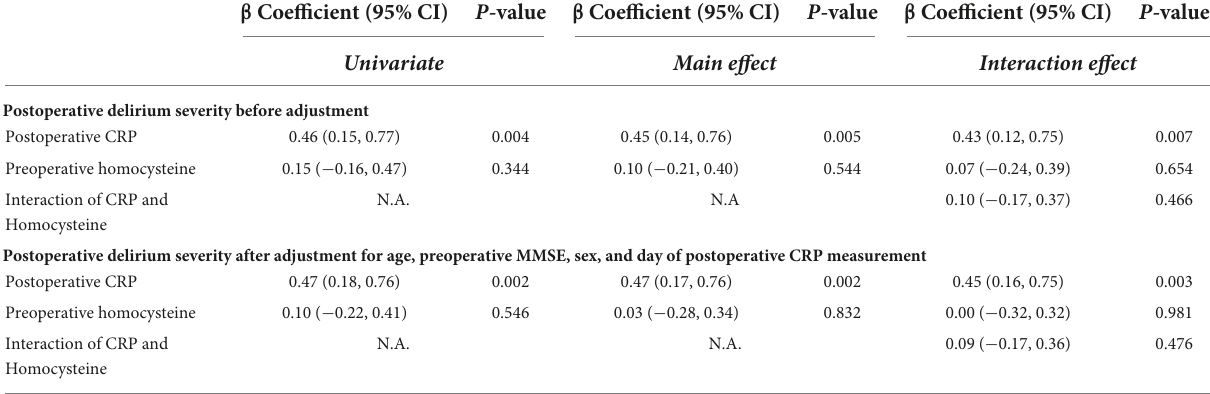
TABLE 3 The association between the severity of postoperative delirium and the preoperative homocysteine, postoperative C-reactive protein, or their interaction. β Coefficient (95% CI) P